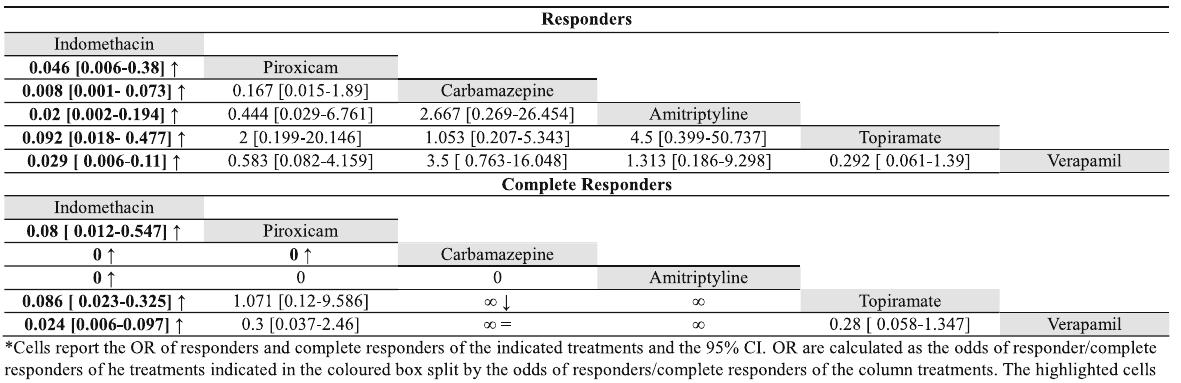
*Cells report the OR of responders and complete responders of the indicated treatments and the 95% CI. OR are calculated as the odds of responder/complete responders of he treatments indicated in the coloured box split by the odds of responders/complete responders of the column treatments. The highlighted cells indicate a p -value of the test of equality of odds lower than 0.05. Arrows indicate if the column treatment is better ( ↑ ) or worse ( ↓ ) than the coloured boxes'